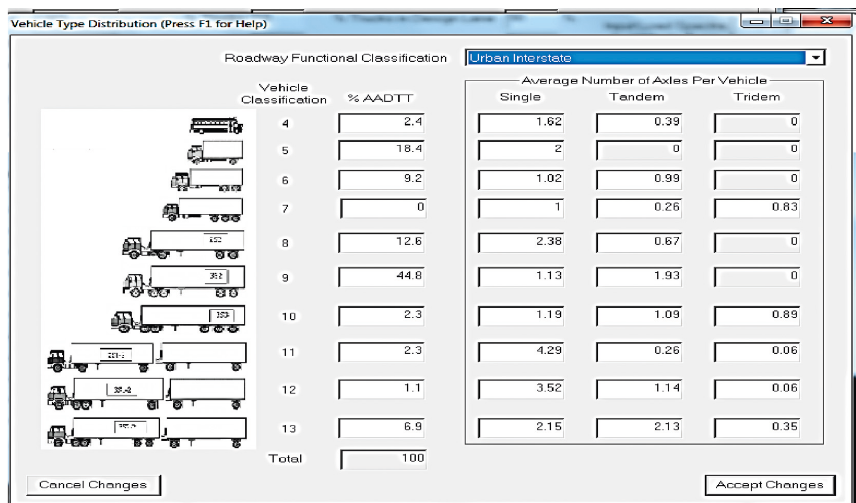
Figure 8: Vehicular load classification used in PerRoad 3.5.